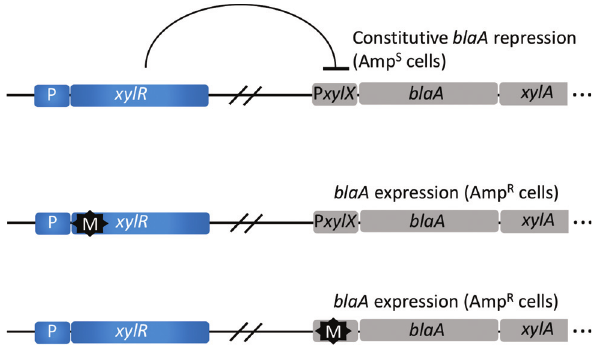
Figure 1 - Rationale of the xylbla marker. The xylX gene in the xyl operon has been replaced by blaA . Nevertheless, repression by XylR in the ab- sence of xylose renders cells phenotypically Amp S . Cells can become phenotypically Amp R by loss of function mutations (M) in xylR , or by mu- tations in the xylR operator inside P xylX